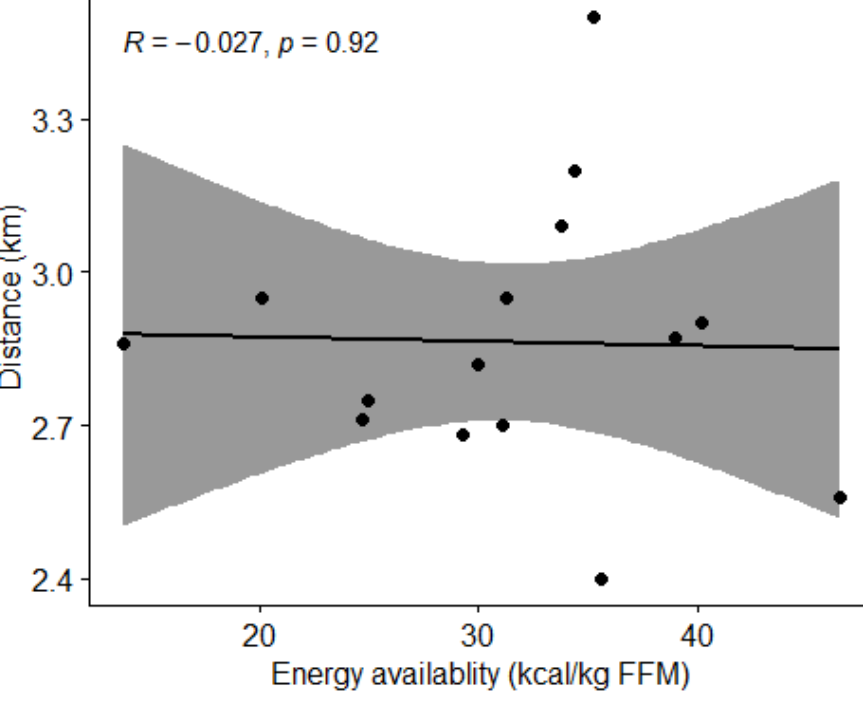
Figure 14. Correlation between energy availability and distance covered by subjects in the Cooper test. Dots represent individual participants ( n = 15). Grey shaded area indicates 95% CI.